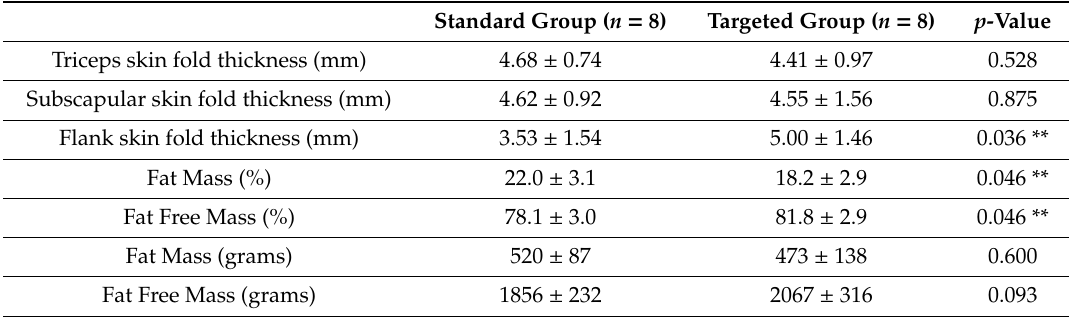
Table 3. Body composition and skinfold thickness in infants who had > 30 days of intervention ( n = 16) 1